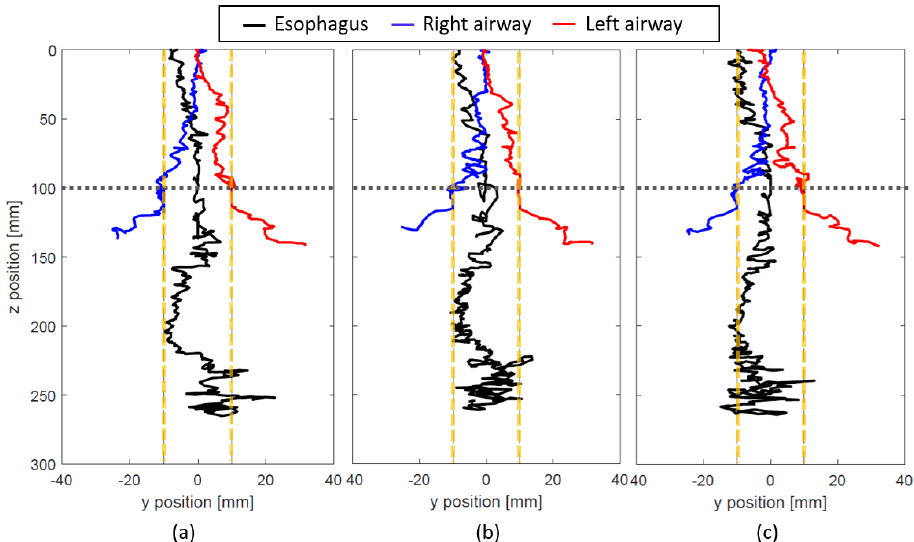
Figure 9. Tracking experiment with the dimensionally accurate mock-up esophagus and airway when L = 100 mm. Three trials of inserting the NGT into each path (the esophagus (black), right airway (blue), and left airway (red)) are shown in ( a – c ). The inner diameter of the esophagus and trachea is represented by the yellow vertical dashed lines. The horizontal dashed line indicates the vertical location of the